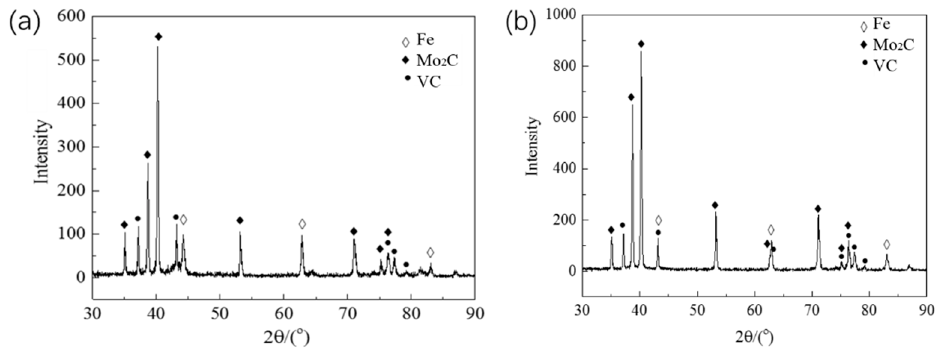
Figure 6. XRD pattern of HSS at different modes: ( a ) As-cast; ( b ) ESR.